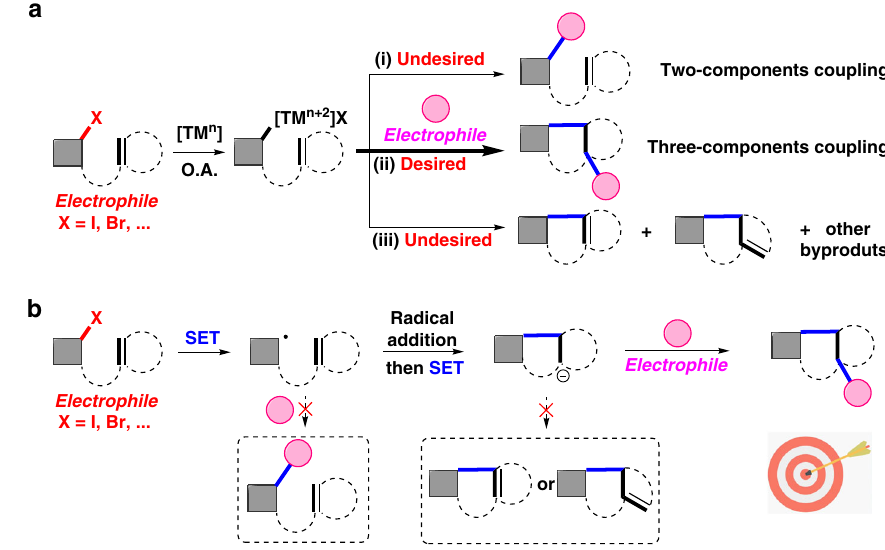
Fig. 1 Strategies for tandem reductive couplings. a Widely investigated transition-metal-catalyzed reductive coupling via two electron transfer process. (i) ipso reductive coupling, (ii) tandem reductive cyclization/coupling, (iii) β -hydride elimination or isomerization as other side reactions. b Rarely investigated radical-type reductive coupling via successive single-electron transfer process. O.A. oxidative addition, SET single-electron transfer. The gray square represents common organic structure. The pink circle represents organic